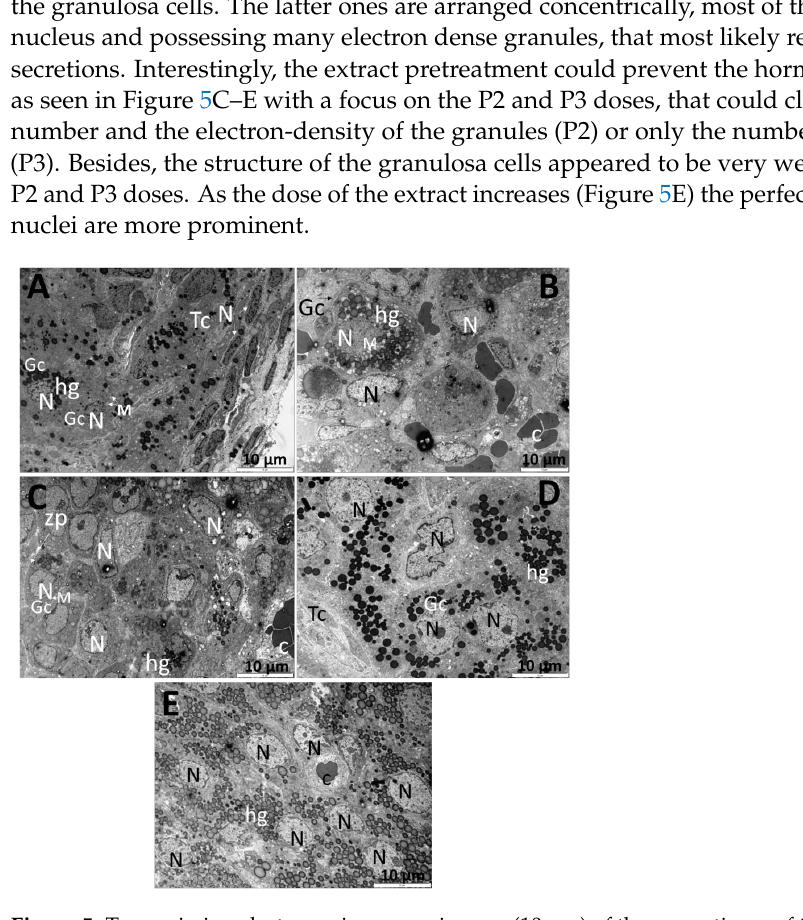
Figure 4. The oestrus stages determined by vaginal cytology (pro-oestrus (P), oestrus (E), metoestrus (M) and dioestrus (D)) in Control, CPA, and CPA + P1/P2/P3 groups. The oestrus cycle respects a